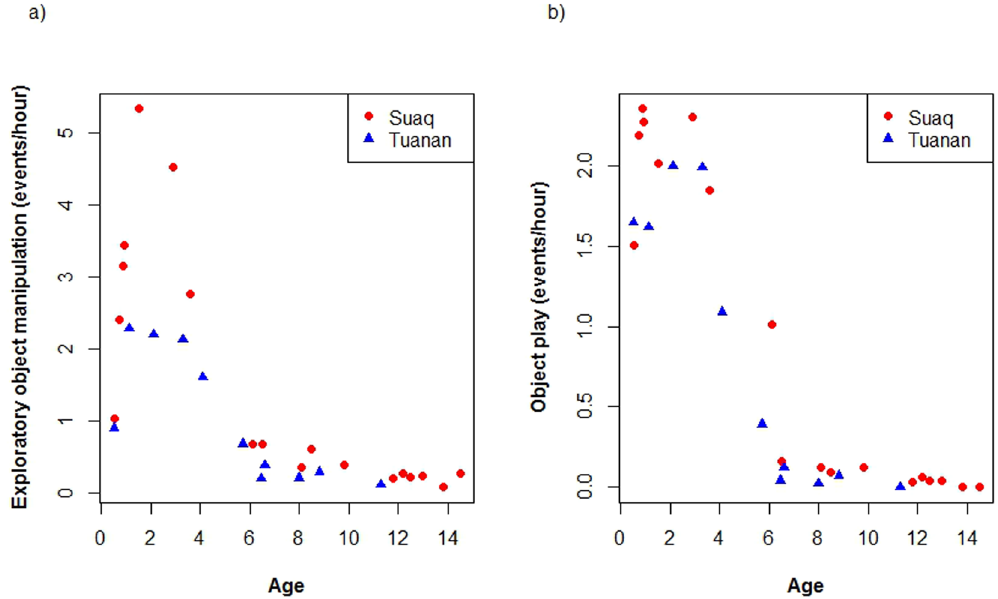
Figure 4. Average hourly rates of exploratory object manipulation ( a ) and object play ( b ) versus age for the immatures of Tuanan and